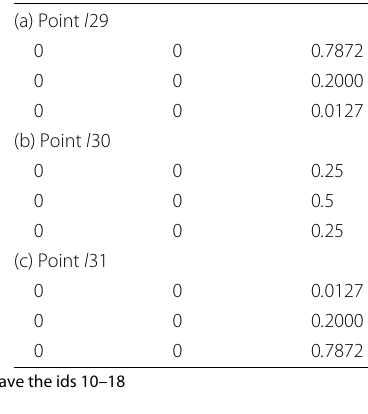
Table 5 Example two-patch model: shape function values N i ( ξ , η ) for the integration points s 29 − 31